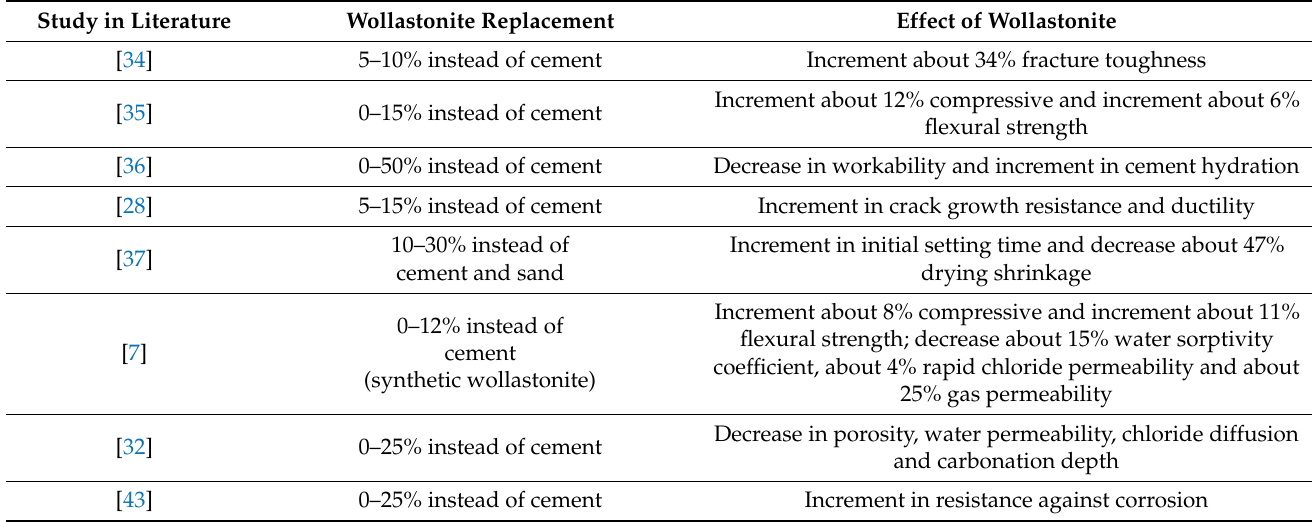
Table 3. Usage and different effects of wollastonite in the